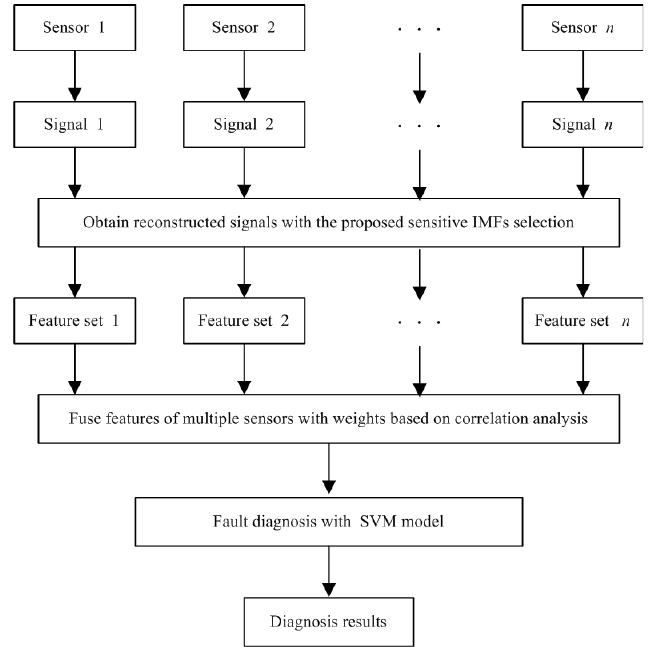
Figure 1. Main procedure of the presented